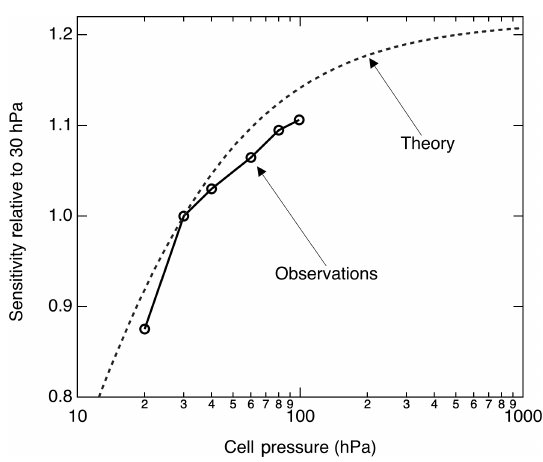
Figure 6. Calculated and measured dependence of the LIF sensitiv- ity on sample cell pressure.